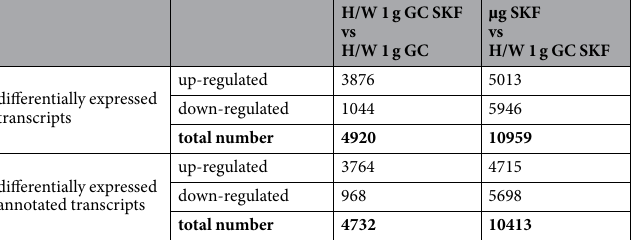
Table 6. Numbers of transcripts that are differentially expressed in comparisons of the experiment groups of the TEXUS-49 suborbital ballistic rocket campaign containing the ion channel blocker SKF-96365. Differential expression is defined as t-test p-value < 0.05; fold change ≤− 1.3 or ≥+ 1.3. The arrays comprise 45034 transcripts of which 42947 are annotated to a gene.